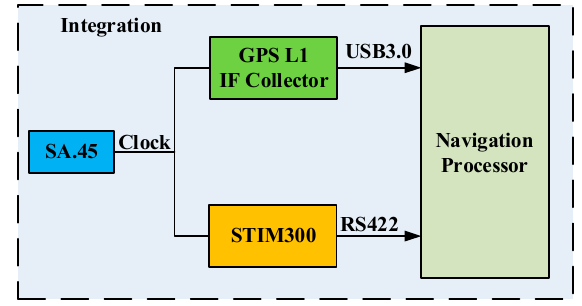
Figure 2. Hardware structure of the demo setup.